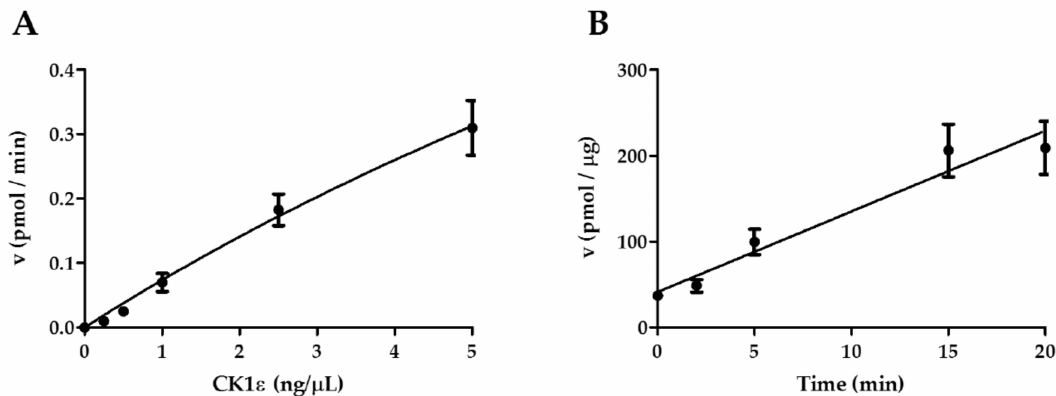
Figure 1. Preliminary set-up of Casein Kinase 1 epsilon (CK1 ε ) enzymatic activity. ( A ) CK1 ε titration curve. A fixed concentration of substrate (casein) (3.12 µ M) and ATP (30 µ M) were incubated with serial dilutions of the enzyme (0.25–5 ng / µ L) for 10 min. ( B ) Time course of CK1 ε kinase activity in the presence of fixed concentration of substrate (casein) (3.12 µ M) and ATP (30 µ M) and of CK1 ε (25 ng). Bars indicate the mean of three independent measurements ± SD (Standard